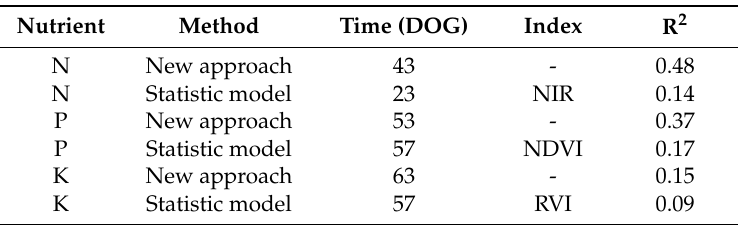
Table 10. The accuracy of SAN simulations.